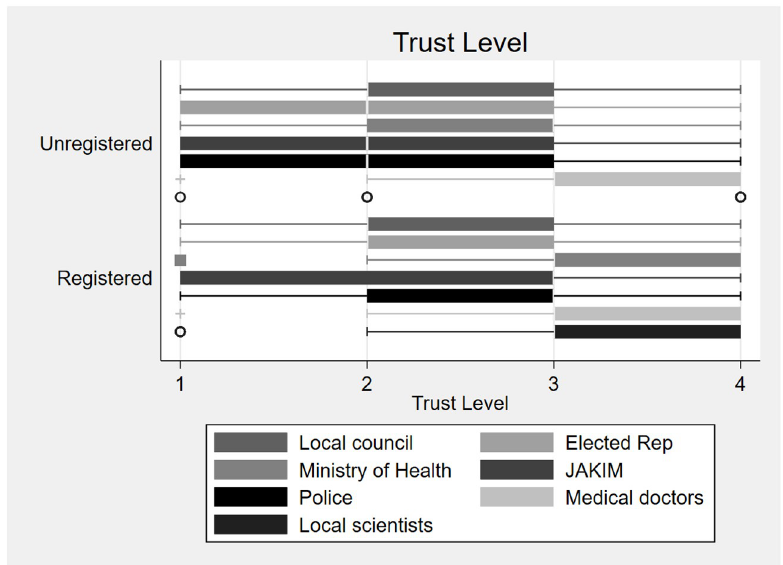
Fig 3. Expectations on population support towards policies designed to increase COVID-19 vaccination take-up by respondents’ registration status. At this stage of the survey, we did not specify policy tools that would serve as punishment or incentives. We also did not distinguish between monetary or intrinsic incentives, so respondents were free to assume any positive incentive that they thought effective for